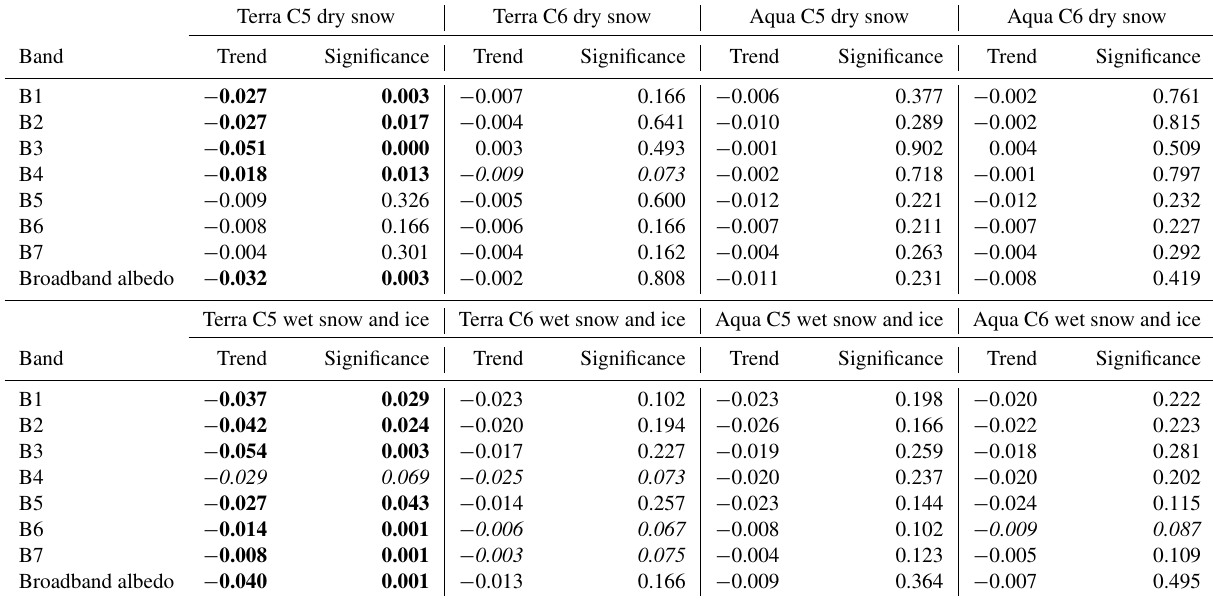
Table 2. Trends (decade − 1 ) and statistical significance of trends for M*D09A1 surface reflectance bands 1–7 and M*D10A1 broadband albedo. Statistically significant (where p ≤ 0.05) trends are in bold, and marginally significant trends (where p = 0.05 to 0.1) are in